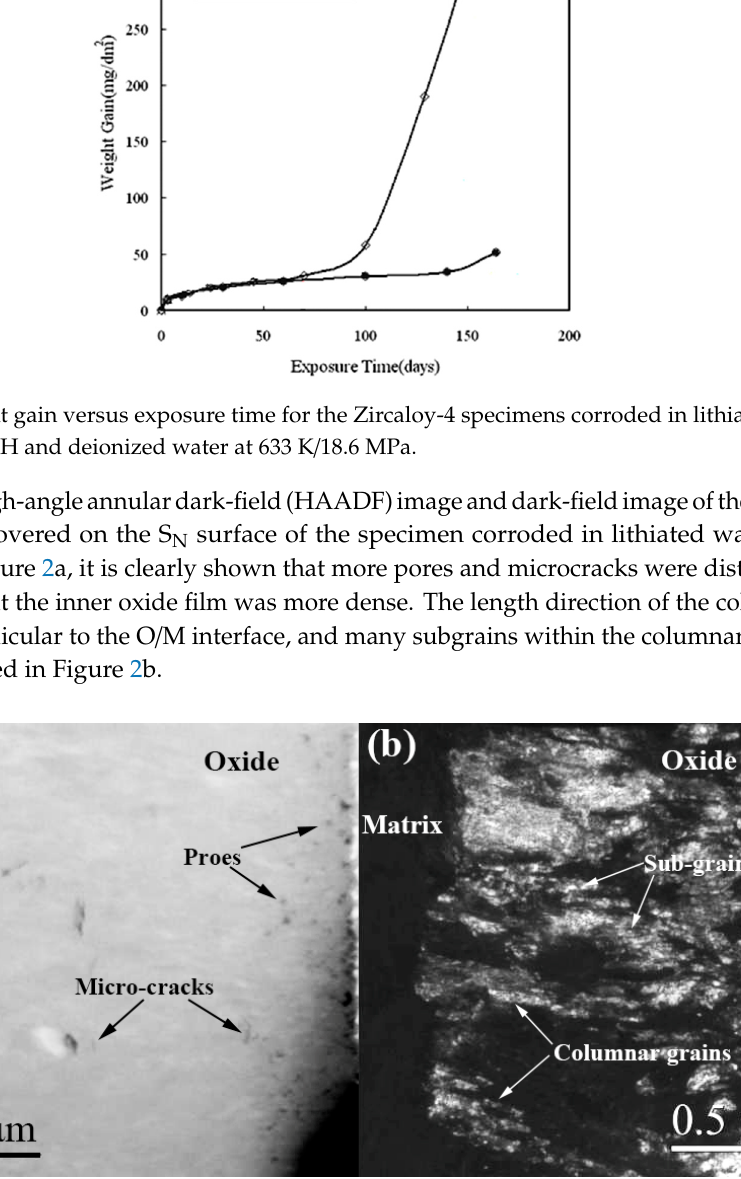
Figure 2. A high-angle annular dark-field (HAADF) image ( a ) and dark-field image ( b ) of the cross-section of the oxide film formed on the S N surface of Zircaloy-4 corroded in lithiated water for 70 d.